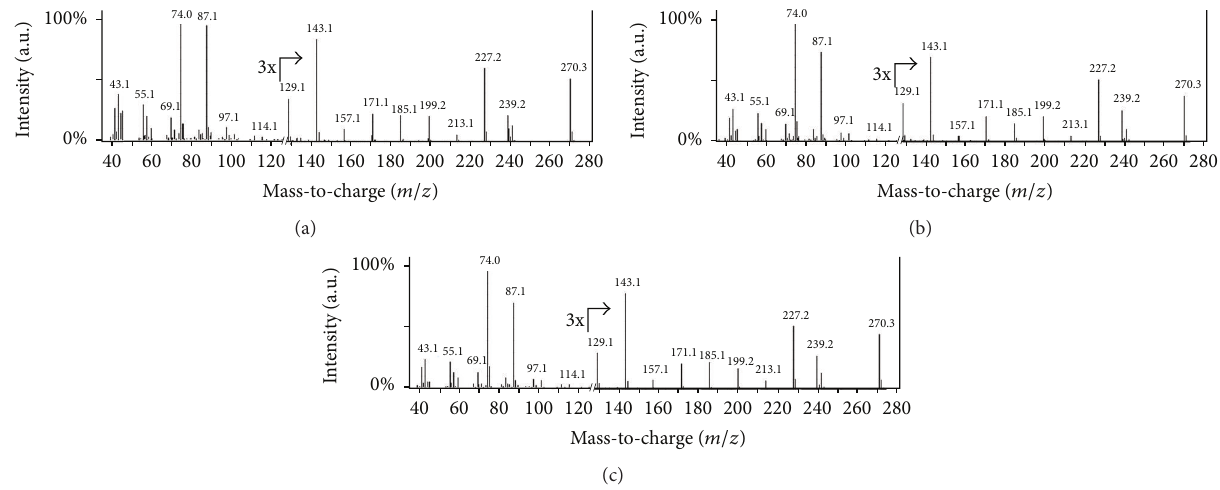
Figure 4: Comparison of the fragmentation patterns of fatty acids from cell extracts and standards. Representative mass spectrum for hexadecanoic acid (C16:0) from S. solfataricus cell extract (a), I. hospitalis-N. equitans coculturecell extract (b), and C16:0 fatty acid standard (c). Low and high mass fragments match intensity with the C16:0 standard, indicating that this fatty acid is present in the cell extract of these archaeal organisms. The region above 120 m/z has been expanded 3-fold on the 𝑦 -axis as indicated by the arrow to better visualize these low intensity